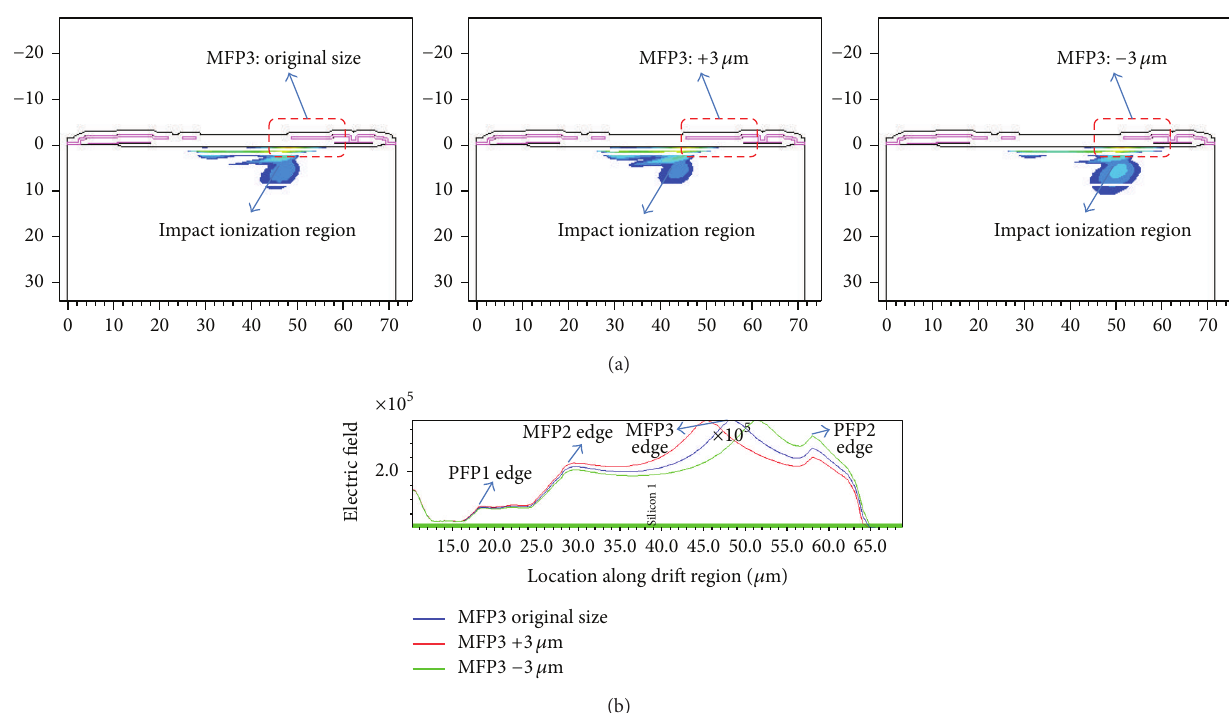
Figure 3: (a) Simulated impact ionization at breakdown voltage; (b) lateral electric field distribution of drift region from source to drain.